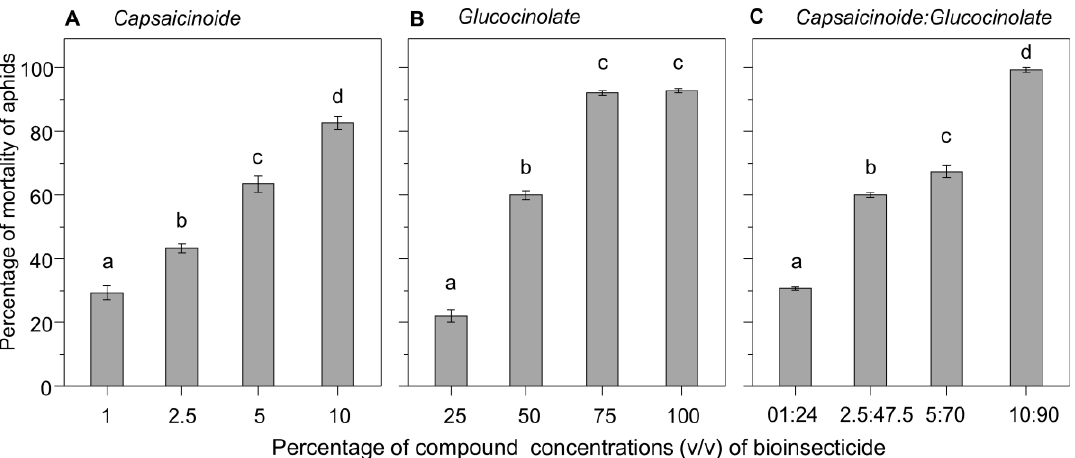
Figure 2. Percentage of mortality of Aphis cytisorum exposed (in the laboratory) to different concentrations of ( A ) capsaicinoids, ( B ) glucosinolates, and ( C ) a mixture of these two compounds. Different letters above error bars indicate significant statistical difference ( P < 0.05) in mean values between treatments.